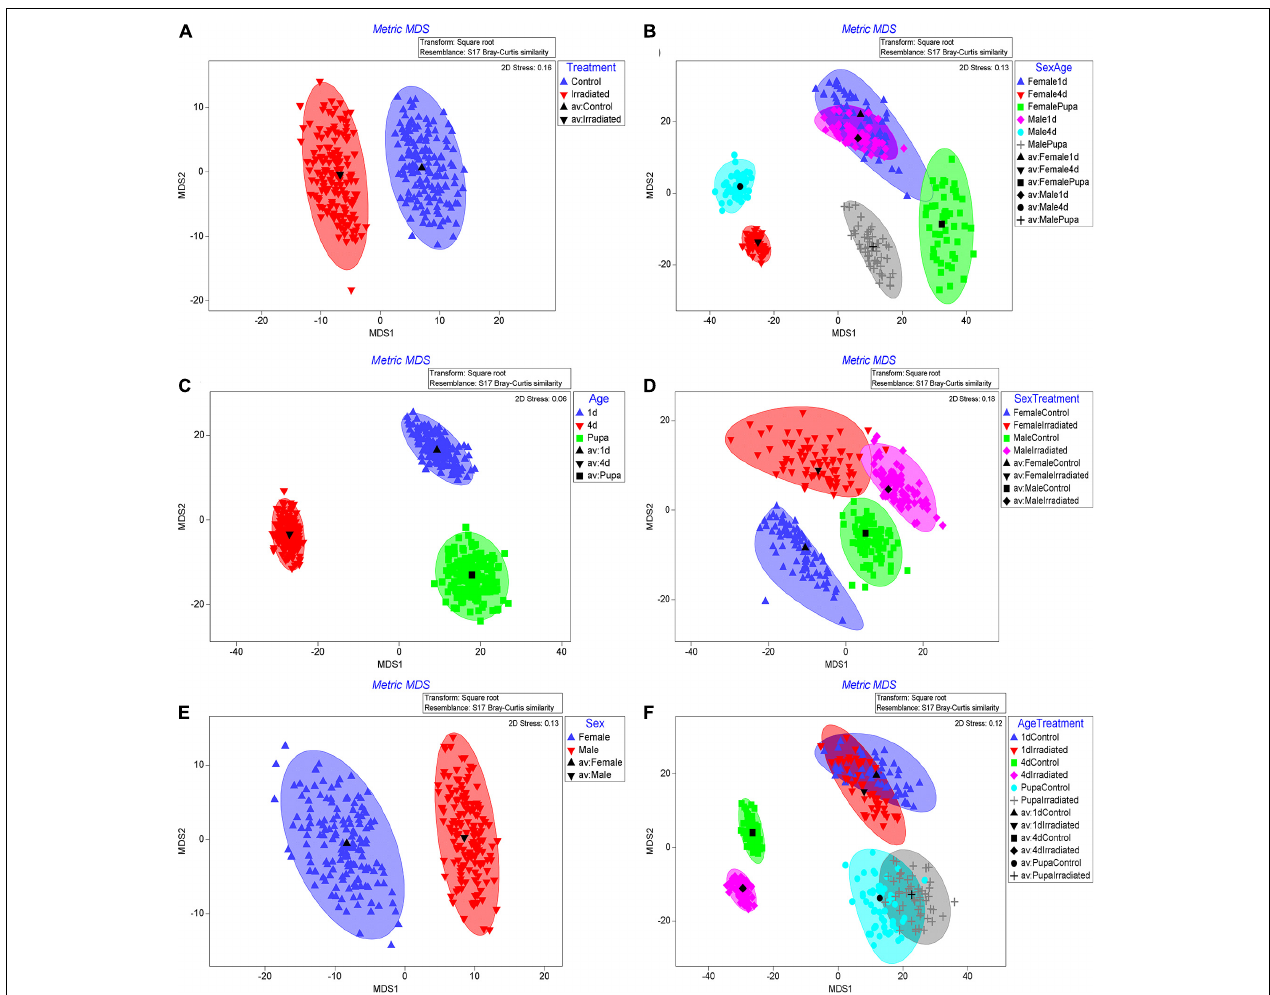
FIGURE 3 | Bootstrap averages with Metric multidimensional scaling (mMDS) of bacterial communities based on relative abundances of OTUs originating from treatment, age or sex groups (A–C) or combinations of them (D–F) . OTUs abundance results from qiime2 analysis were transformed with square root transformation and the resemblance matrix was conducted with Bray Curtis similarity. Bootstrap averages were analyzed with 5 (D,F) , 75 (E) and 150 (A–C) bootstraps per sample indicated by the number of points in the